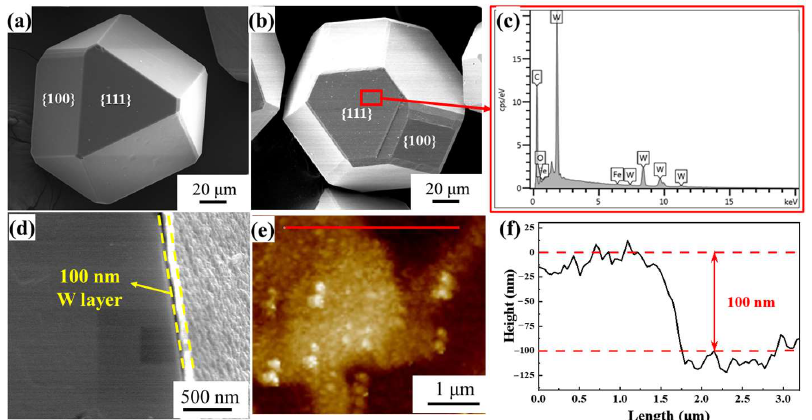
Figure 1. The morphology of diamond particles ( a ) uncoated diamond; ( b )W-coated diamond; ( c ) EDS analysis results of the red areas in ( b ); ( d ) surface morphology of W-coated diamond particles after coating destruction; ( e , f ) diamond morphology characterized by AFM.